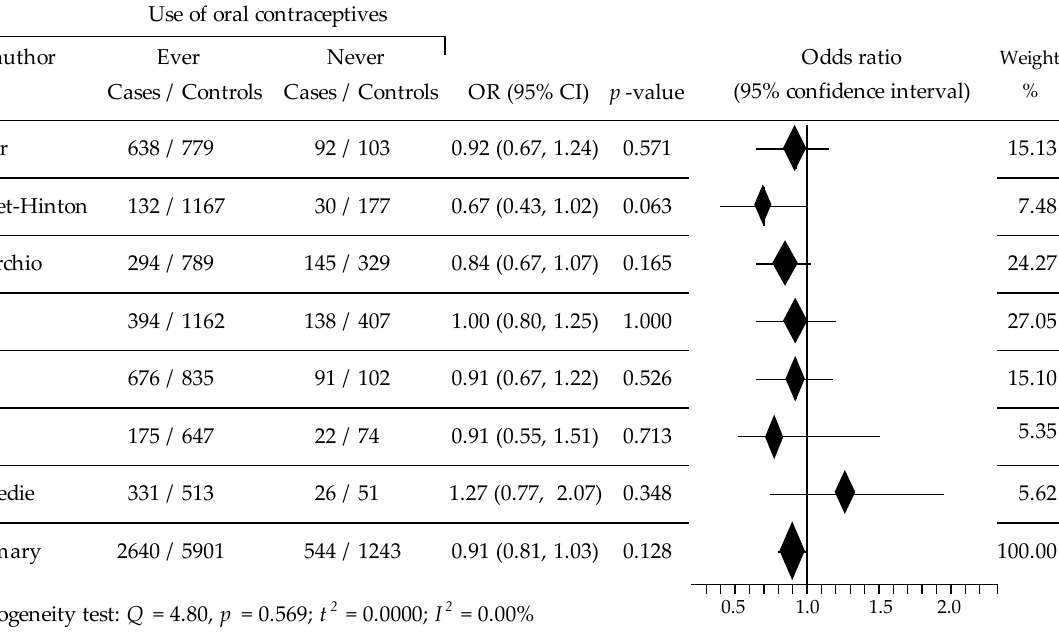
Figure 2. Forest plot for the association of OC intake on the risk of ER+BC.